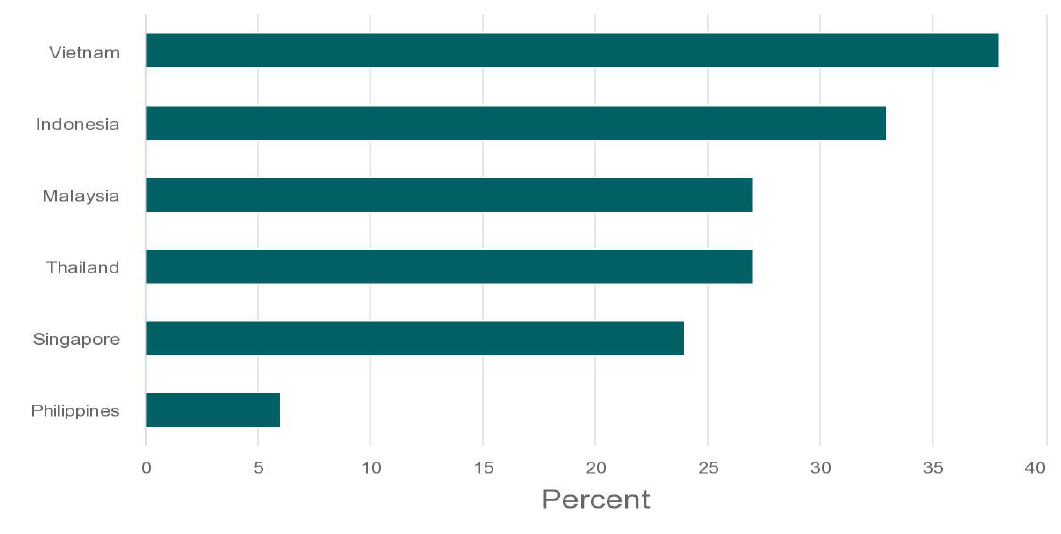
Figure 8: Surge in Obesity in Southeast Asia